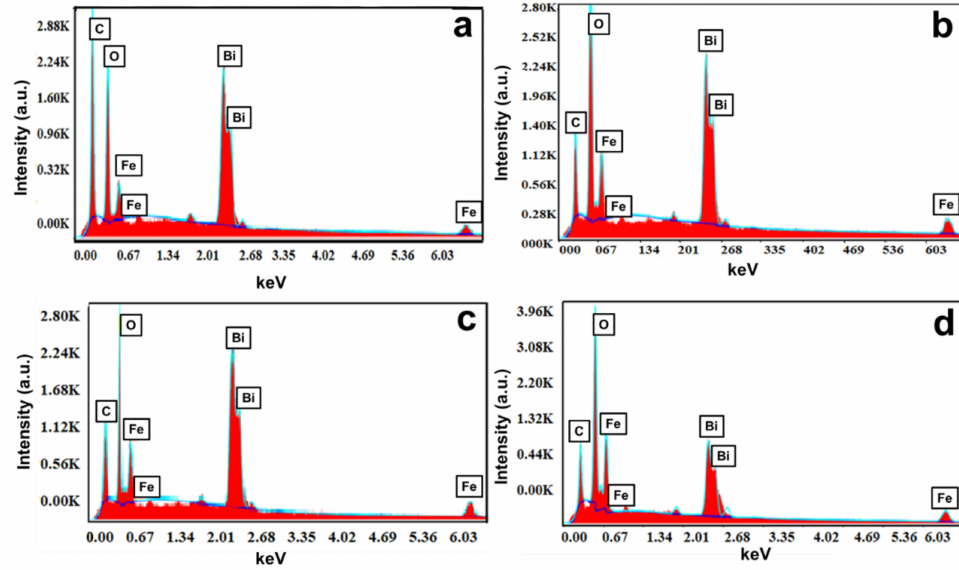
Figure 6. EDS micrograph of ( a ) BFO-C, ( b ) BFO-S, ( c ) BFO-L, and ( d ) BFO-M